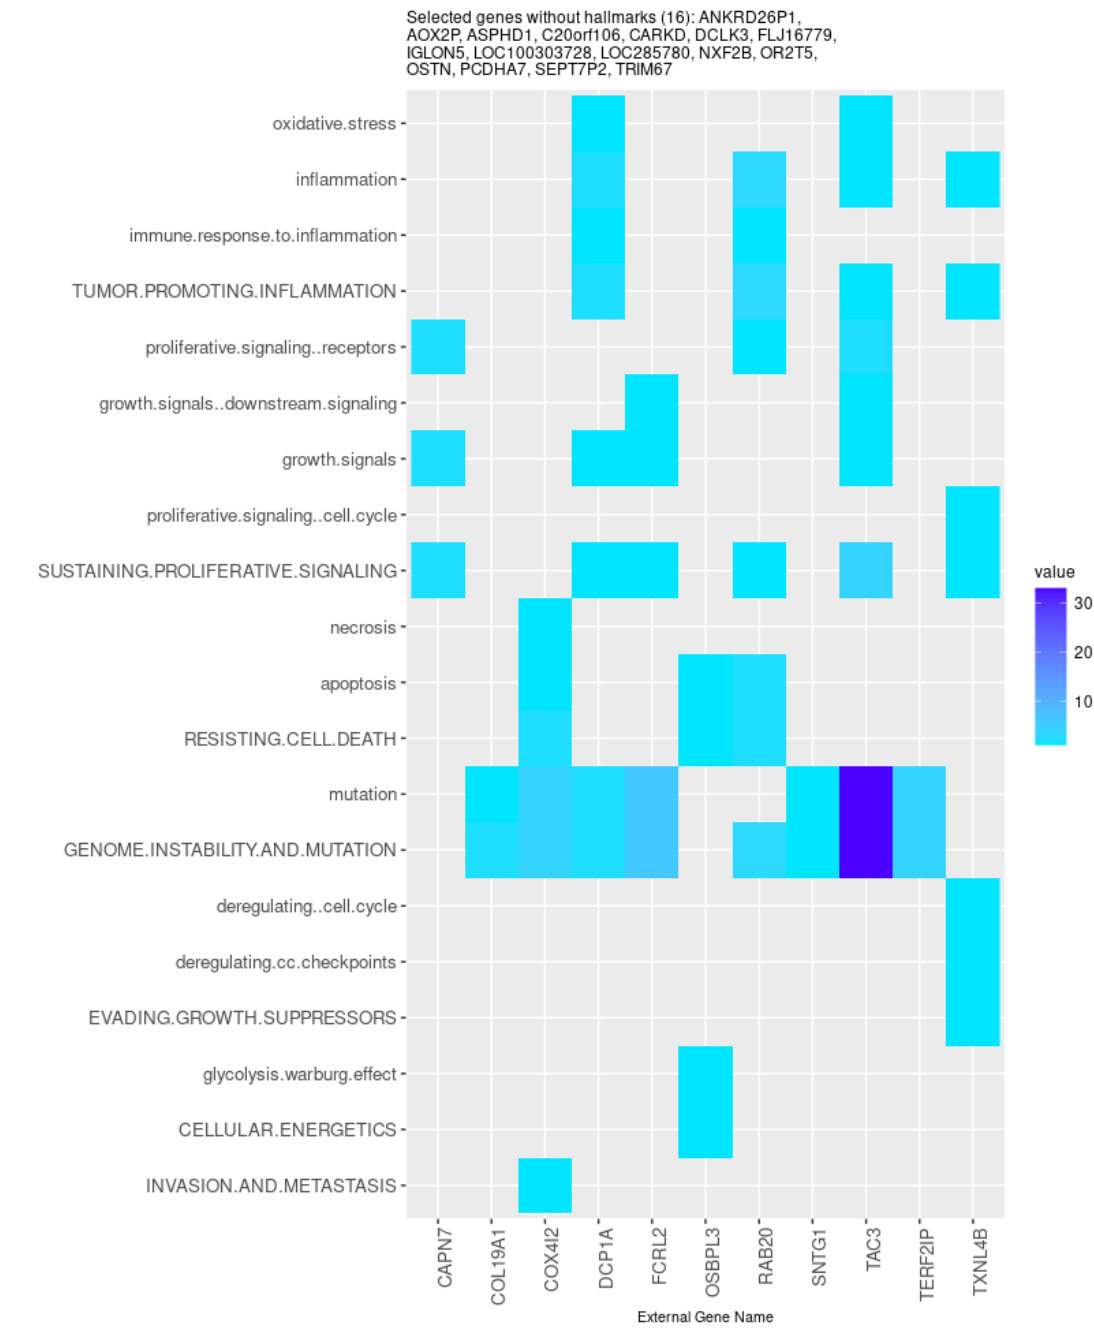
Figure 8. Genes selected by the TCox method associated with the hallmarks of cancer, given by the CHAT. The value corresponds to the number of hits found in the literature, where light and dark blue correspond to a low and high number of hits,